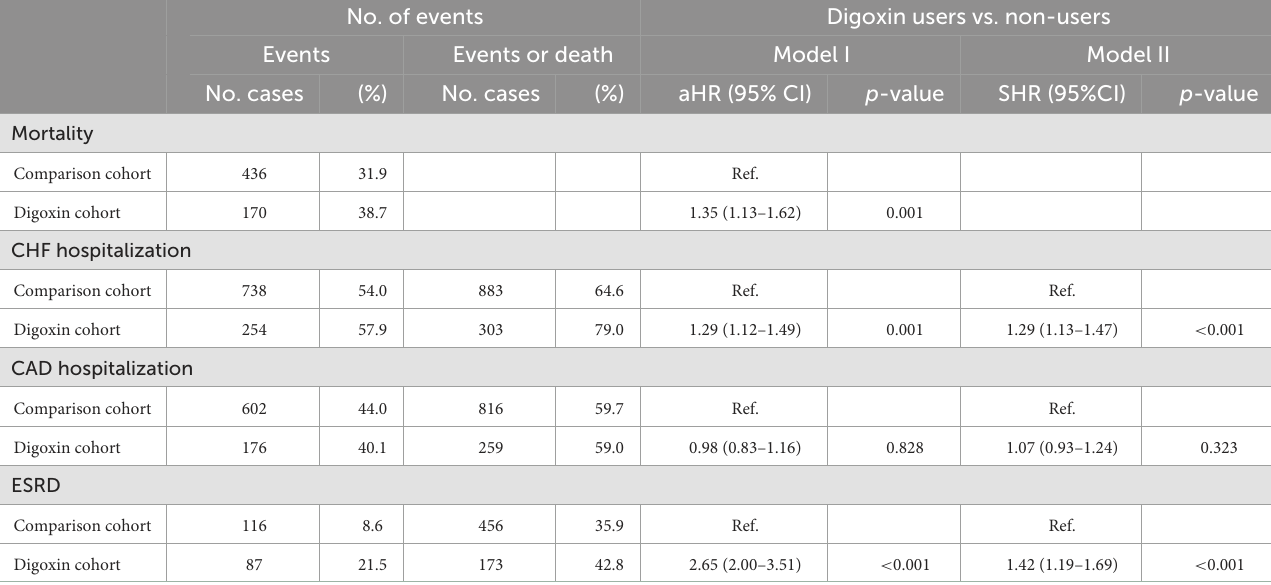
ModelI:adjustedcoxproportionalhazardregressionmodel.